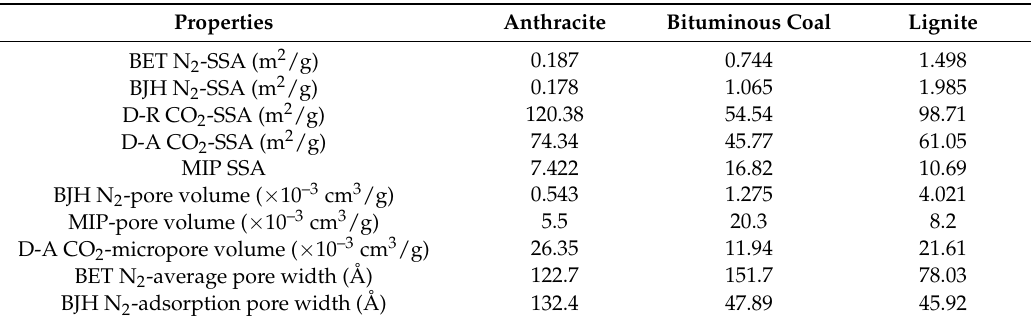
Table 1. Structural properties of the coal